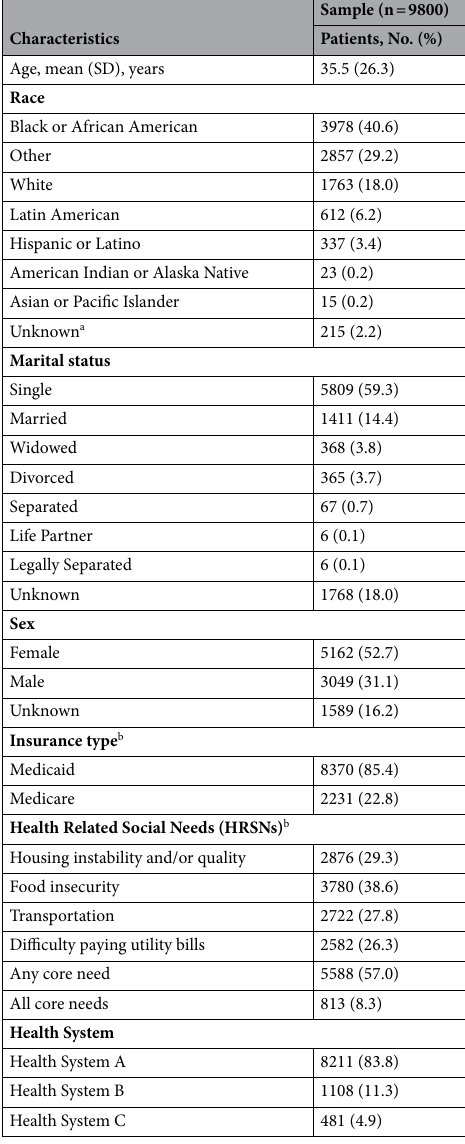
Table 1. Demographic Characteristics and Health-Related Social Needs (HRSNs) of CMS Beneficiaries in the Accountable Health Communities (AHC) Model in the Greater Houston Area, September 2018 to December 2020. a Includes "Unknown", "Declined", "Not Answered” responses and records that had no response. b Patients could be in multiple categories so numbers do not sum to